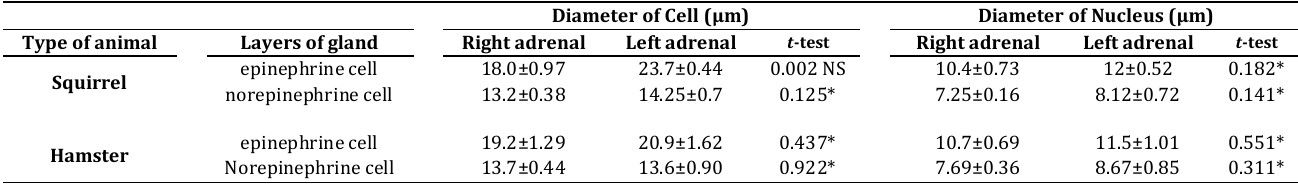
Table 1. The diameter of the cells and nuclei of different parts of the adrenal glands of squirrel and hamster Diameter of Cell (μm) Diameter of Nucleus (μm) Type of animal Layers of gland Right adrenal Left adrenal t -test Right adrenal Left adrenal t -test epinephrine cell 18.0±0.97 Squirrel